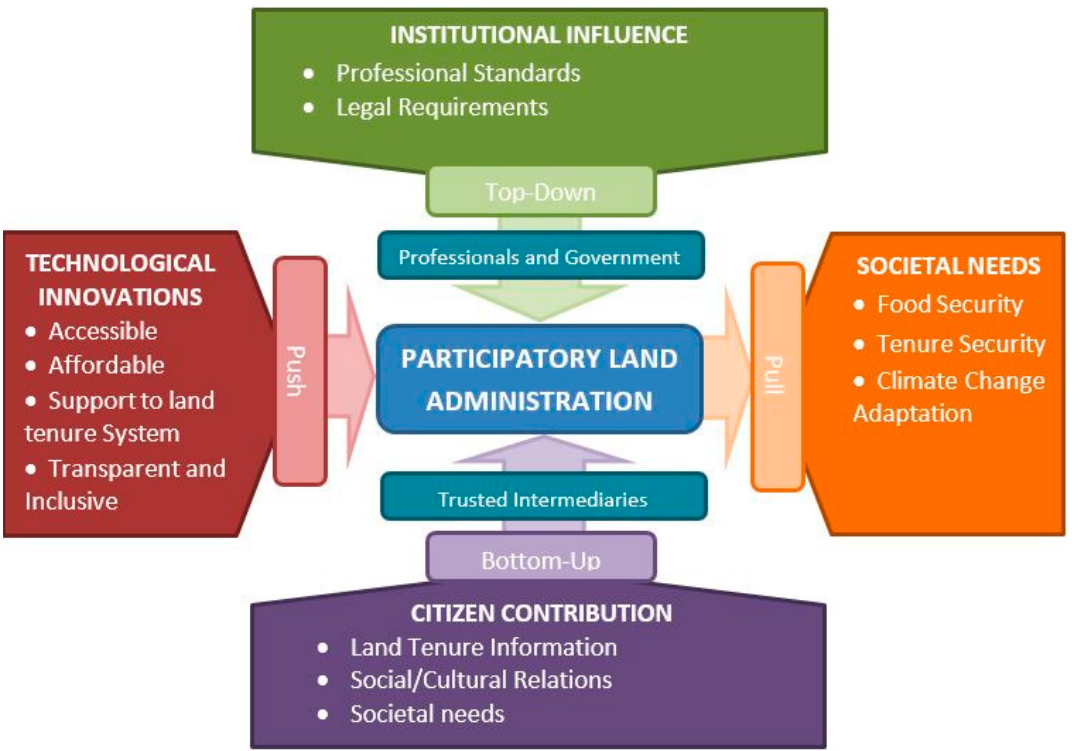
Figure 1. Structure of Participatory Land Administration (The Societal Need considered in this paper is Food Security).